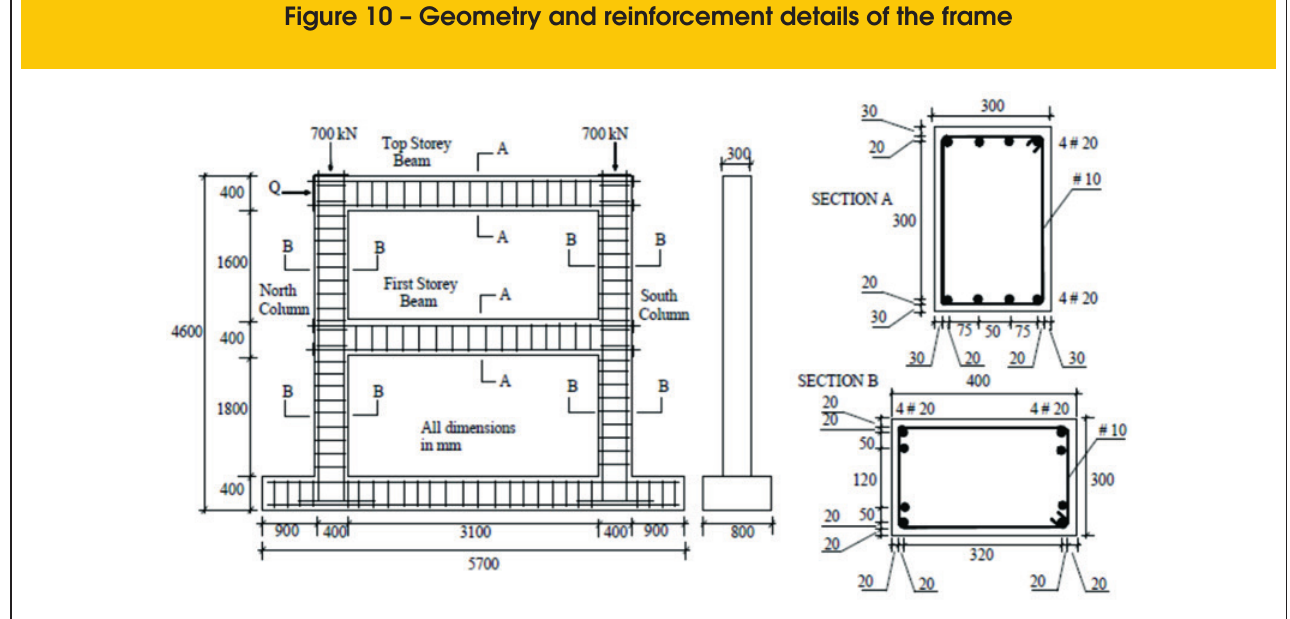
Figure 10 – Geometry and reinforcement details of the